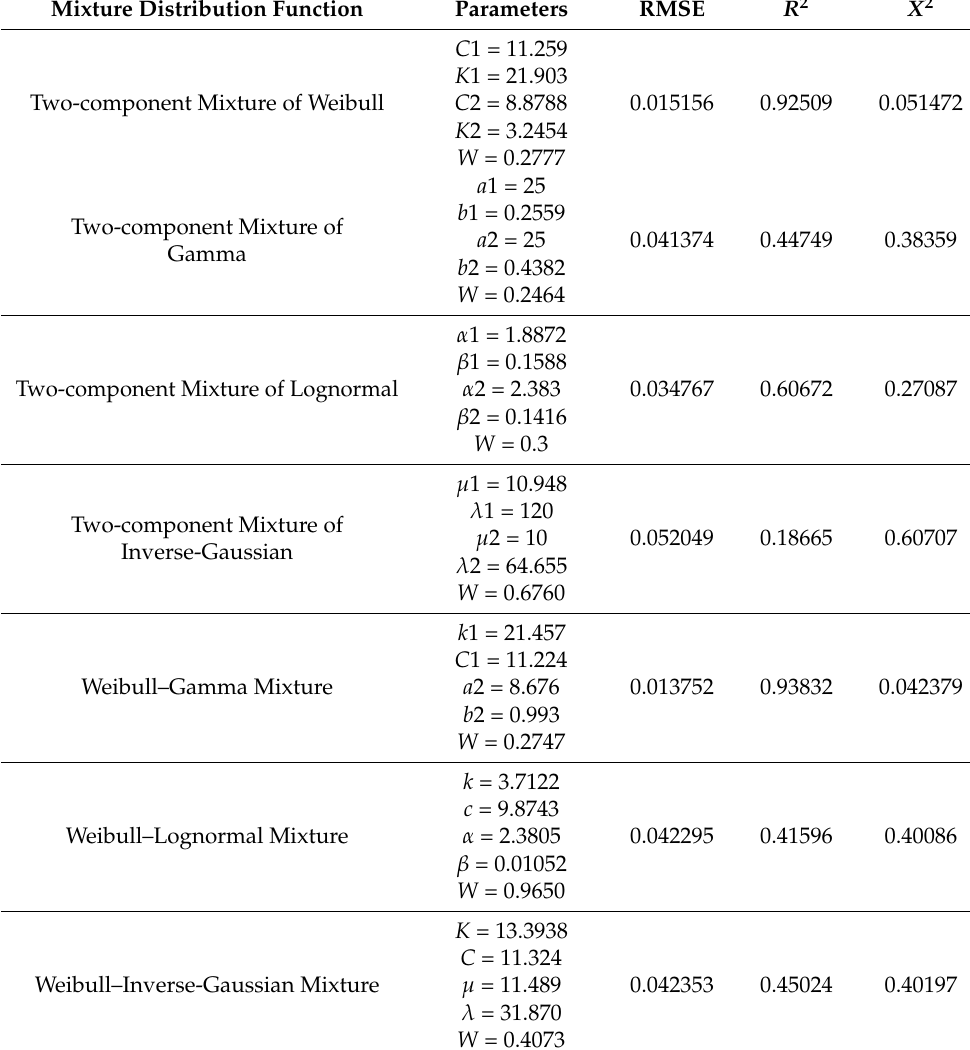
Table 5. Probability distribution parameters for the two-component mixtures of PDFs in the solar irradiance modeling.